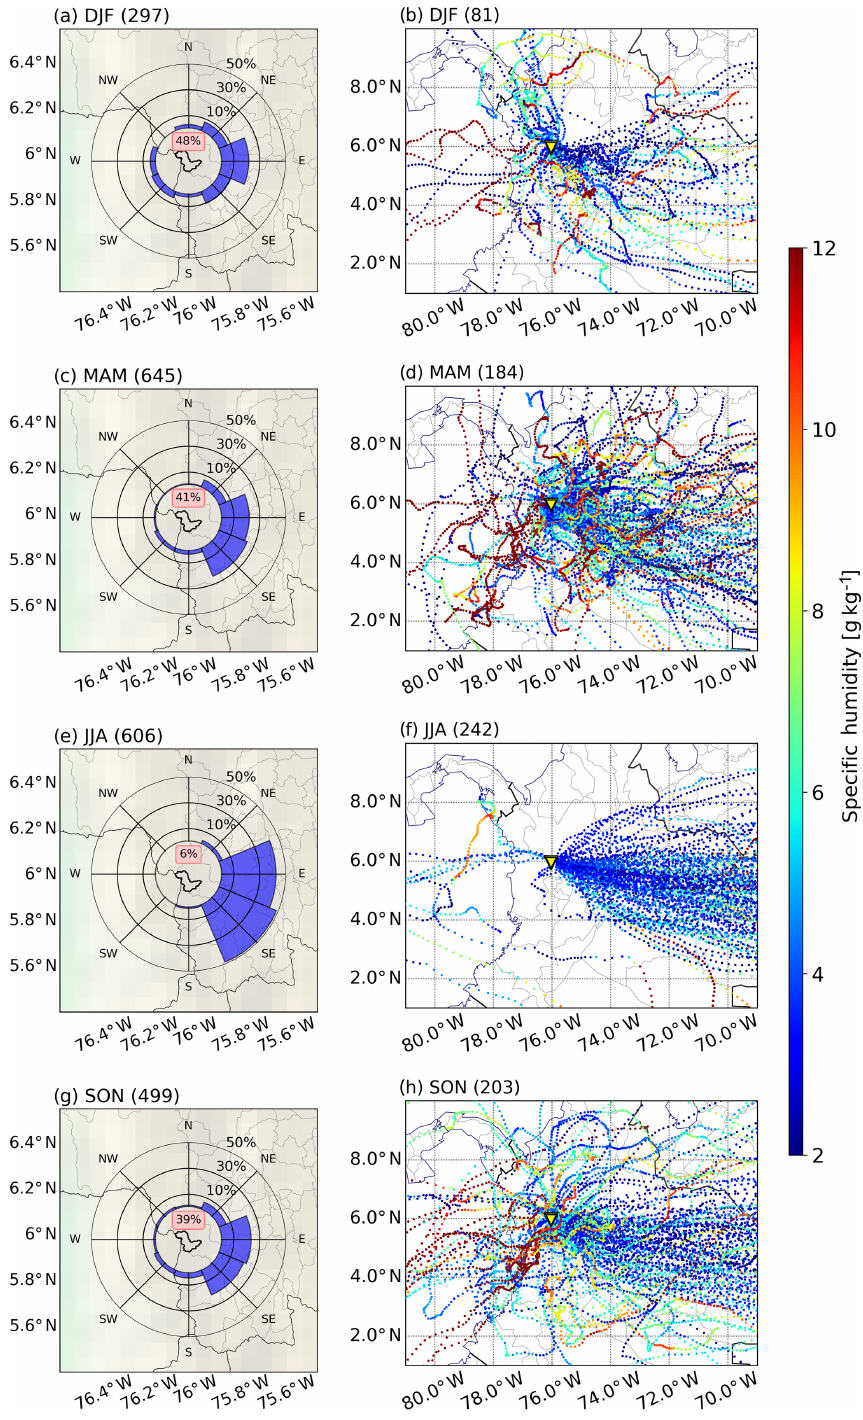
Figure 6. Seasonal predominant precipitation tracks estimated using radar retrievals (a, c, e, g) and the back-trajectory and specific-humidity analysis arriving at 500hPa over the La Liboriana basin (b, d, f, h) for the December-to-February (DJF), March-to-May (MAM), June- to-August (JJA), and September-to-November (SON) quarters, respectively. The percentage in the center of the diagrams in (a, c, e, g) corresponds to the portion of the events categorized as of local formation. Each panel includes, in the title, the number of events considered in each